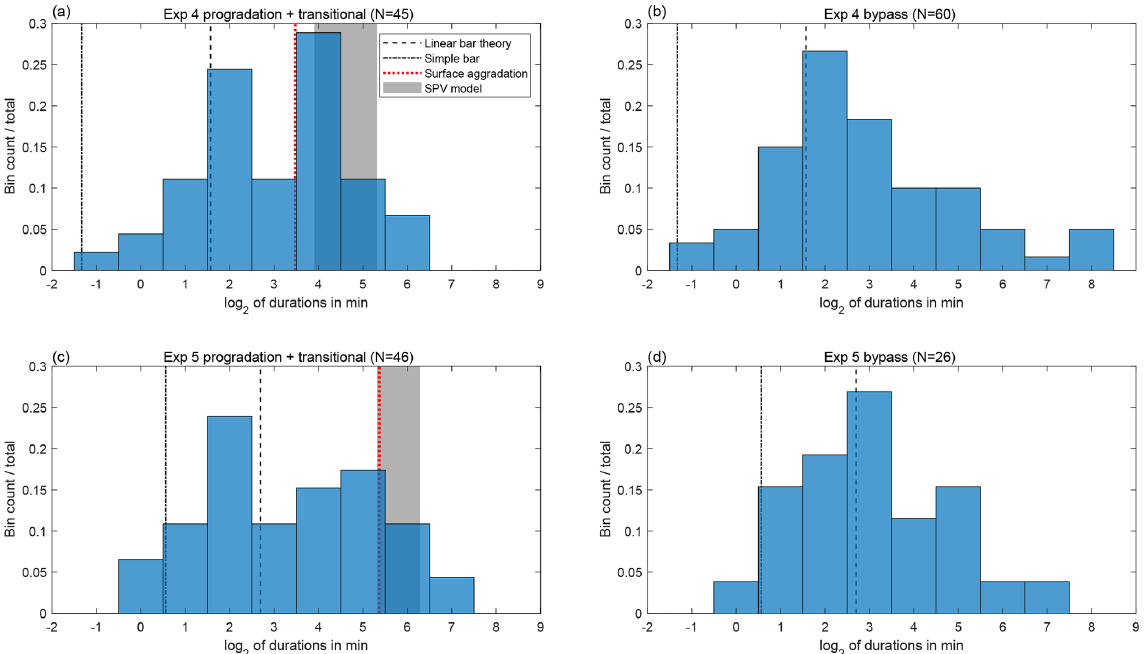
Figure 8. Histograms of durations between switches for experiment 4 progradation and transitional phases (a) and bypass phase (b) and experiment 5 progradation and transitional phases (c) and bypass phase (d) . Theoretical timescales are shown for